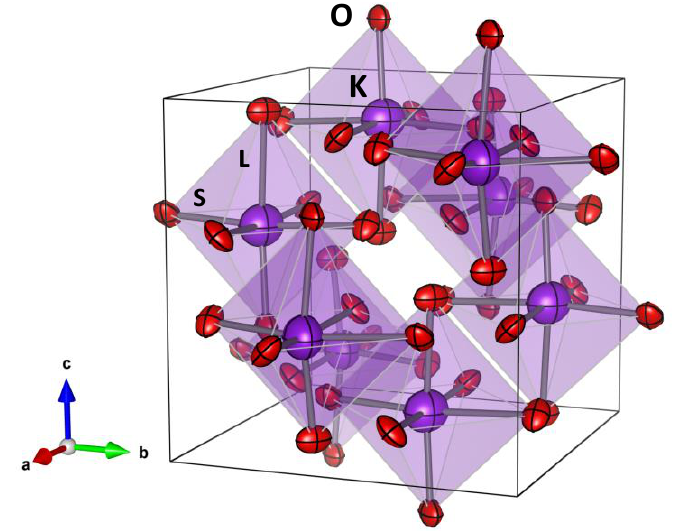
Figure 7. Representation of oxygen K-containing pseudo-octahedral cages. Short (S) and large (L) K–O distances are labelled. (Nb,Te)O 6 octahedra and unbounded O atoms are hidden for clarity.